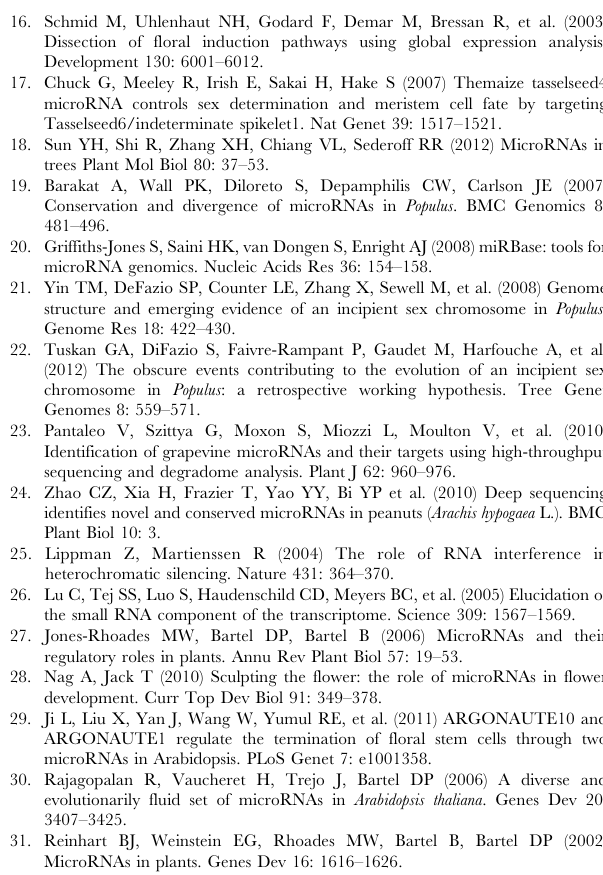
Table S1 134 loci of 38 unique miRNAs. Table S2 11 poplar novel miRNAs were detected in other species. Table S3 miRNAs and their targets. Table S4 Primers for 5 9 RACE mapping of miRNA cleavage sites. Table S5 Real-time PCR primer sequences for candidate miRNAs. Table S6 Real-time PCR primer sequences for candidate